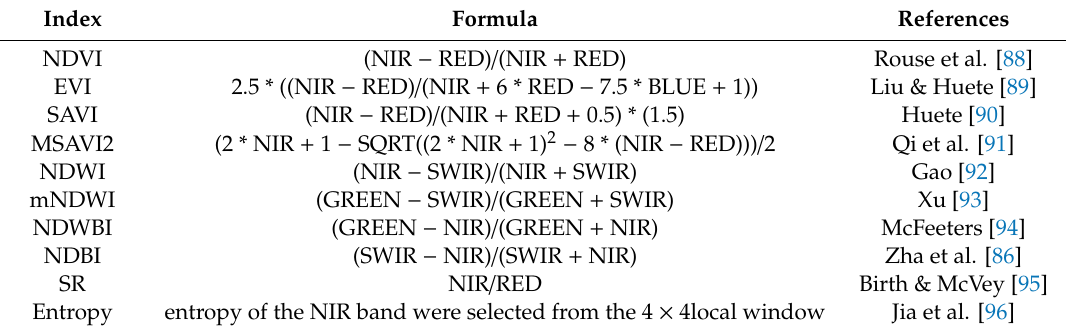
Table A1. Selected auxiliary variables.